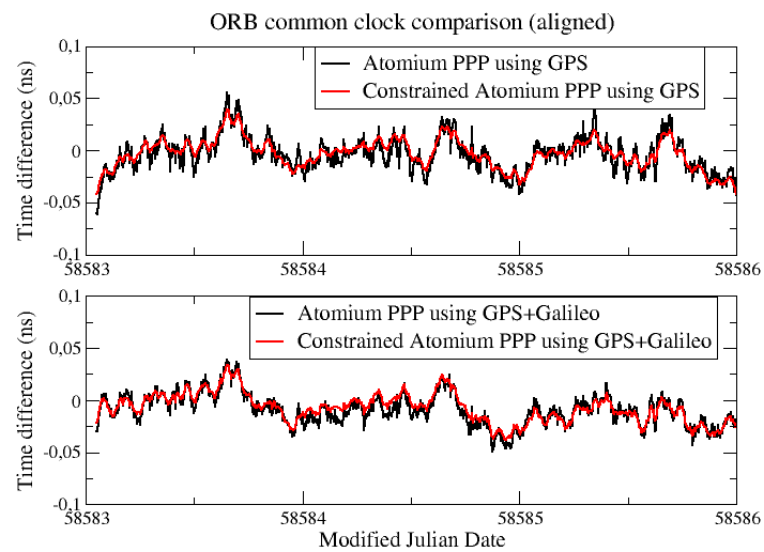
Figure 6. Aligned CCD constrained results in ORB.